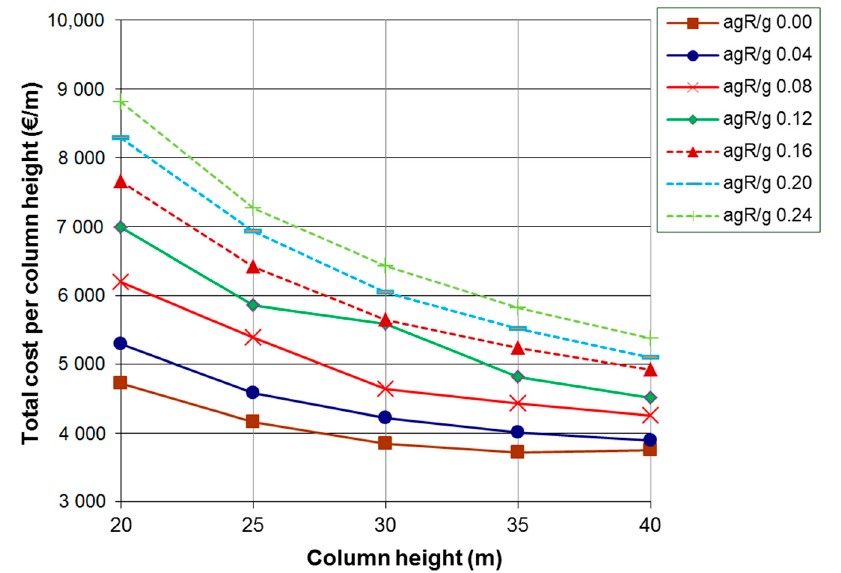
Figure 17. Water tanks total cost per unit height.